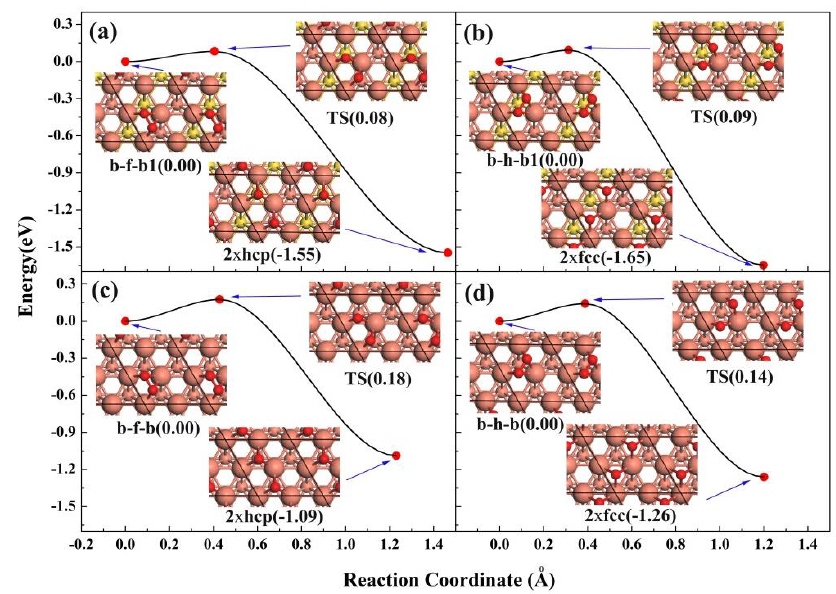
Figure 4. The minimum energy path (MEP) of the dissociation process for: ( a ) b-f-b1 adsorption state on Cu-skin Cu 3 Au(111) surface, ( b ) b-h-b1 adsorption state on Cu-skin Cu 3 Au(111) surface, ( c ) b-f-b adsorption state on Cu(111) surface, ( d ) b-h-b adsorption state on Cu(111) surface. The 2 × fcc (two O occupying a set of neighboring fcc sites) and 2 × hcp (two O occupying a set of neighboring hcp sites) are designated as the dissociation state of b-h-b and b-f-b adsorption configuration, respectively. TS represents the transitions state and the numbers in the brackets represent the energy of each state relative to initial state.